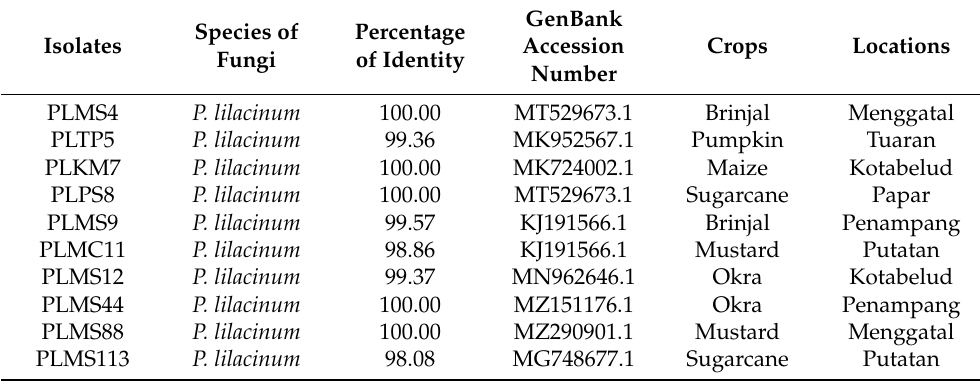
Table 3. Descriptions of proteolytic fungi isolated from different locations in Sabah,